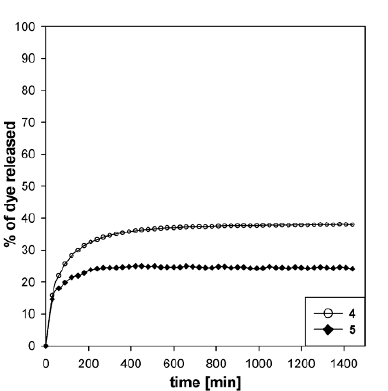
Figure 9. Release of 2 from modified MCM-41 silica at pH= 4.5.